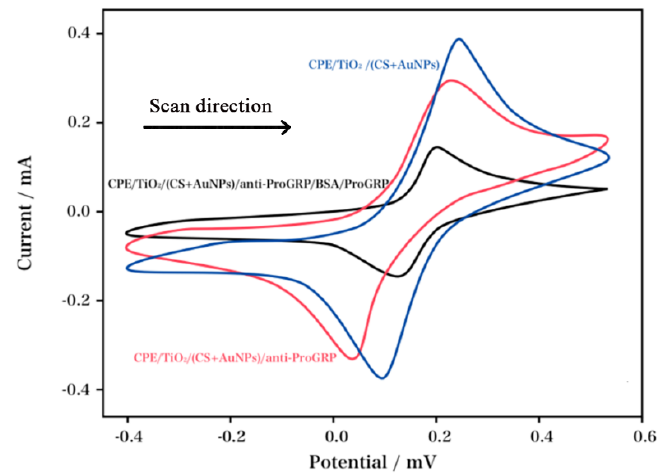
Figure 1. The cyclic voltammetry (CVs) of different electrodes: carbon paste electrode (CPE)/TiO 2 /(CS+AuNPs), CPE/TiO 2 /(CS+AuNPs)/anti-progastrin-releasing peptide (ProGRP) and CPE/TiO 2 /(CS+AuNPs)/anti-ProGRP/BSA/ProGRP.